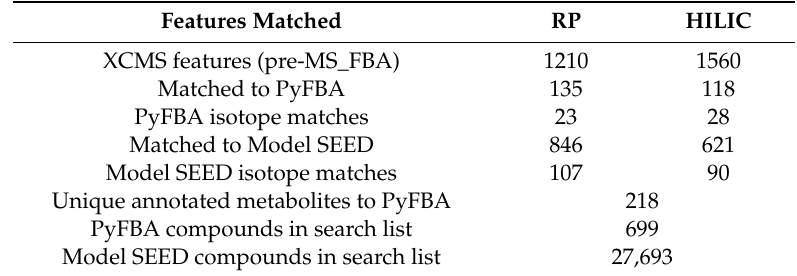
Table 1. Summary of metabolite features matched to reverse phase (RP) and hydrophilic interaction liquid chromatogprahy (HILIC) data using MS_FBA.